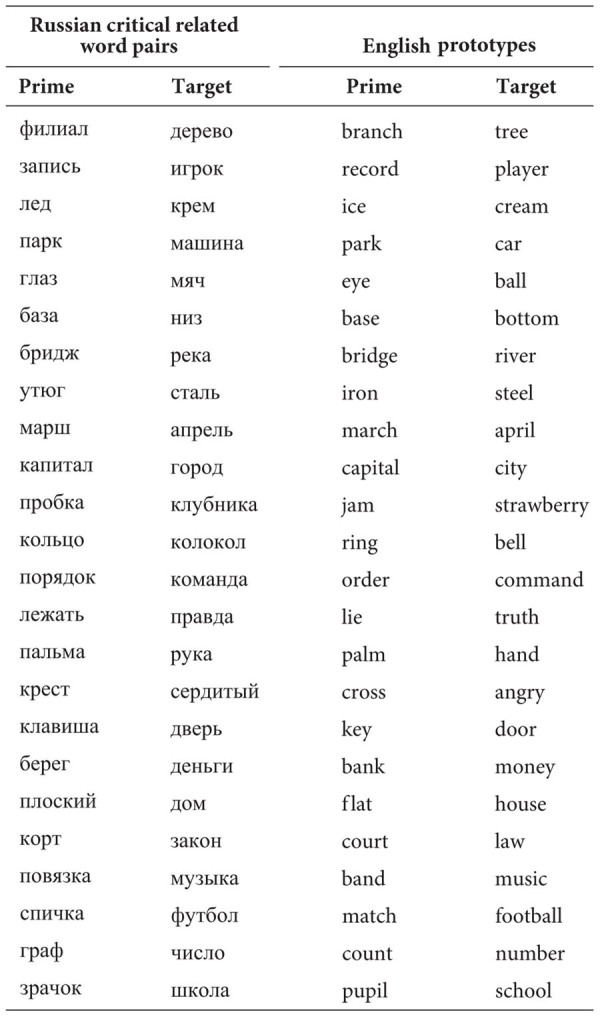
Russian critical related word pairs and their English prototypes.